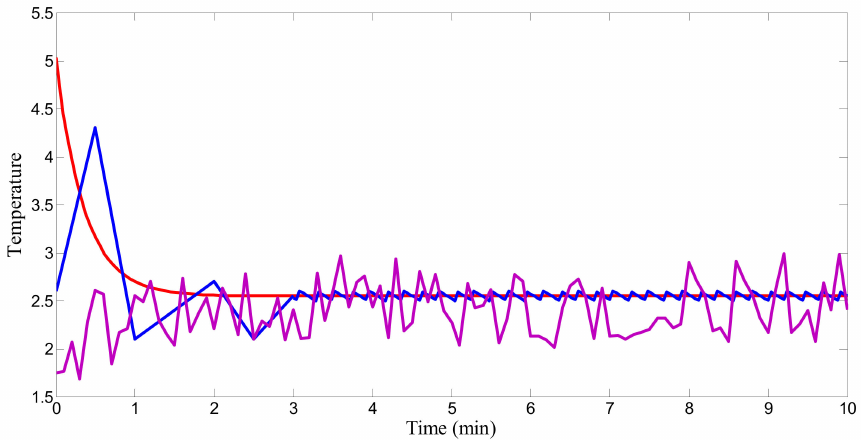
Figure 6. Control input U : (red: Dynamics obtained with FBL, violet: Dynamics obtained with disturbance injected to the model, blue: Dynamics obtained with disturbance injected to the model and sliding mode control).